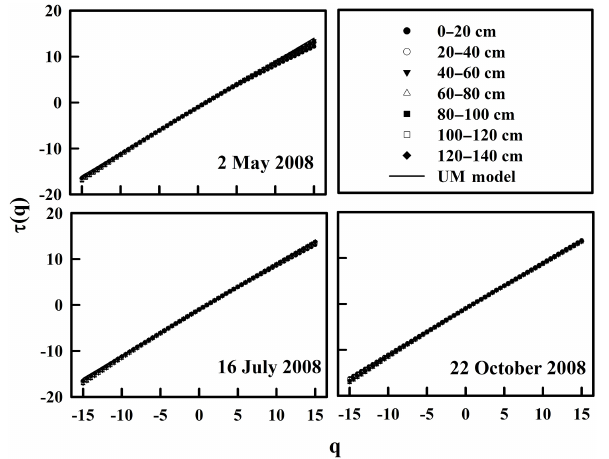
Figure 4. Mass exponents for selected soil water storage spatial series from surface to different soil layers (cumulative storage) at 20cm increment down to 140cm in 2008 for a range of q ( − 15 to 15 at 0.5 increments). The solid line is a linear reference created following the UM model of Schertzer and Lovejoy (1987) passing through ( q =